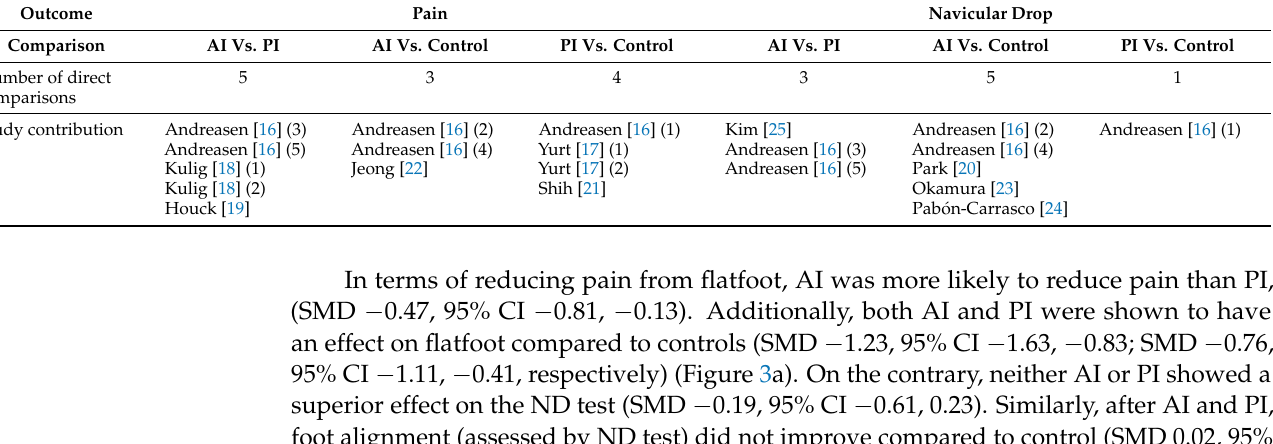
Table 5. Contributions of each study in each comparison. Outcome Pain